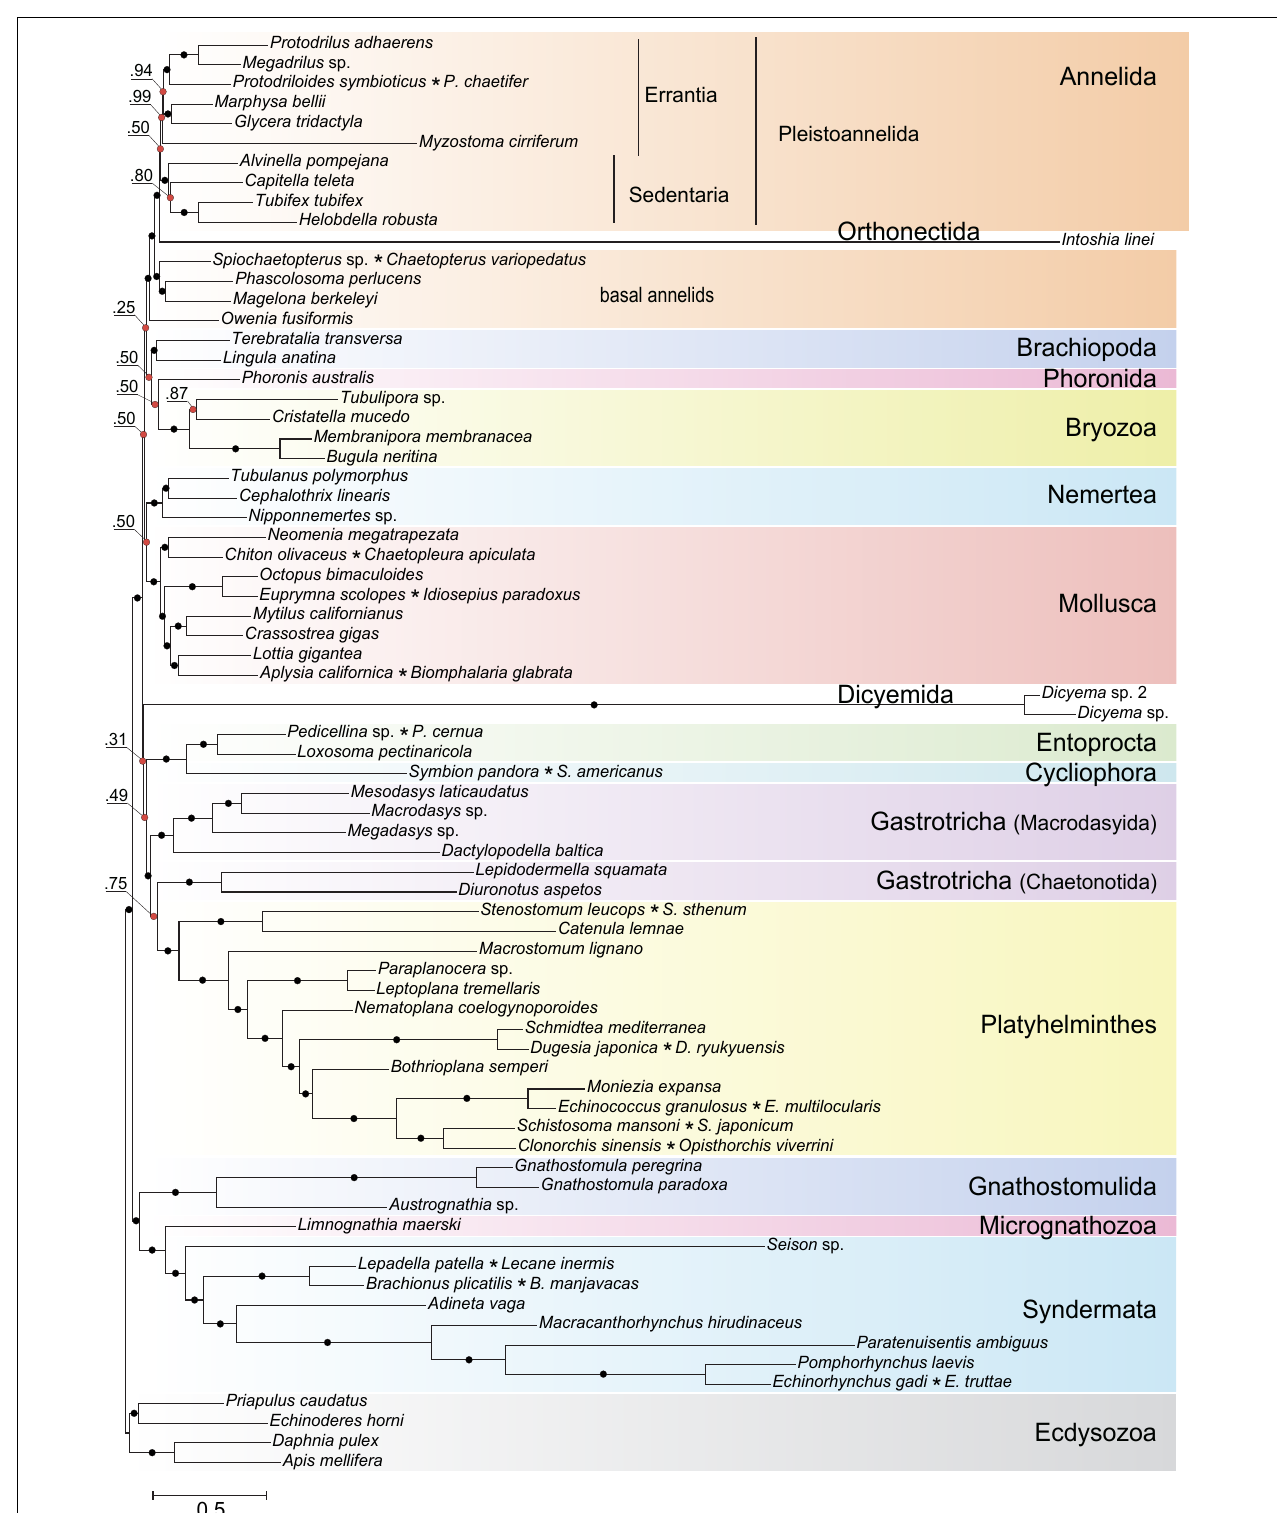
FIGURE 10 | Bayesian tree of Spiralia/Lophotrochozoa with the inclusion of Mesozoa. The consensus topology was constructed from four chains of a PhyloBayes run with the CAT + GTR + (cid:48) 4 evolutionary model. Nodes with posterior probabilities below 1.0 are marked with red dots, with those of 1.0 – with black dots. Chimeric operational taxonomic units include names of merged species signed with an asterisk. The tree is rooted with four ecdysozoan lineages.